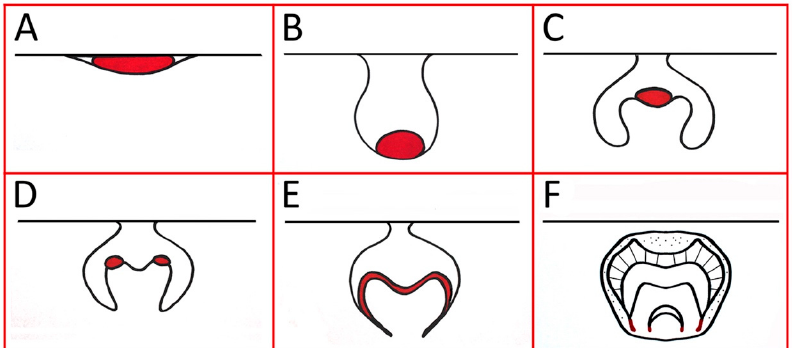
Figure 1. Schematic representation of Shh transcription in the developing tooth (red). ( A ) Initiation; ( B ) Early bud stage (at the tip of the bud in enamel knot precursor cells); ( C ) Early cap stage (in the primary enamel knot); ( D ) Late cap stage (in the secondary enamel knots); ( E ) Bell stage (in the internal enamel epithelium, pre-ameloblasts and stratum intermedium); ( F ) During root development